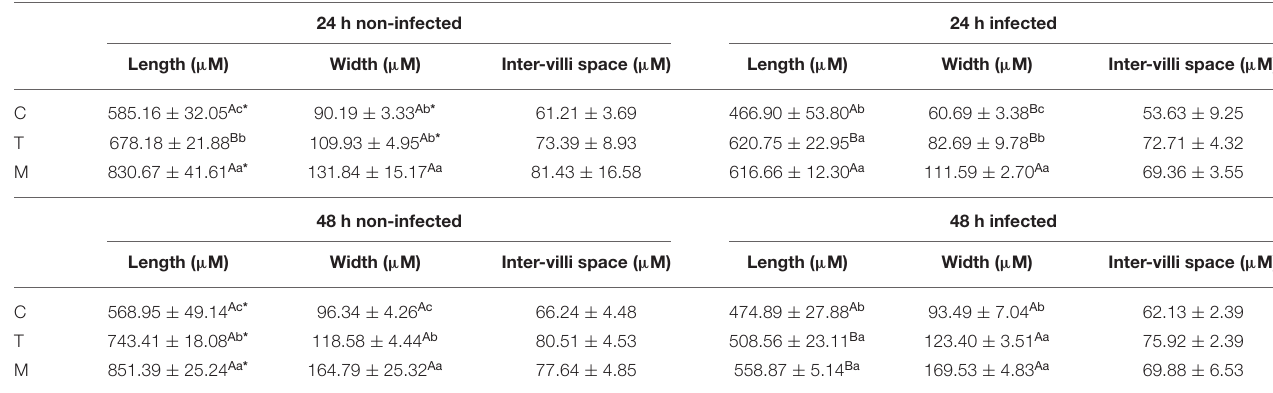
TABLE 6 | Mid-gut morphometry of mono-sex Nile tilapia fed M. oleifera leaf powder containing diet. 24 h non-infected 24 h